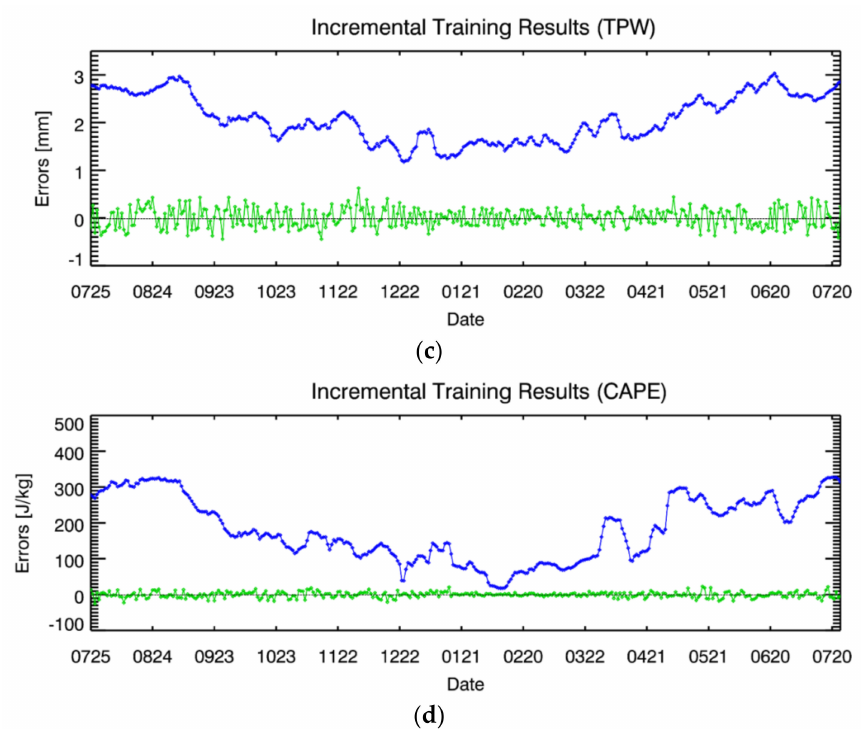
Figure 8. Training performance of the two different ANN models. Scatter plots colored by the density for ( a ) TPW and ( b ) CAPE from the ST learning. The time series of error statistics for ( c ) TPW and ( d ) CAPE from the INC learning results. The green and blue dots represent bias and RMSE,